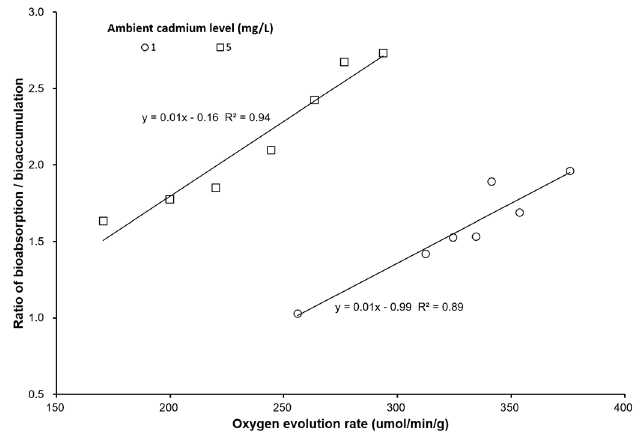
Figure 6. The relationship between the ratio of bioabsorption/bioaccumulation and the oxygen evolution rate ( μ mol/min/g) on S. suiae exposed to 1 and 5 Cd 2+ mg/L.